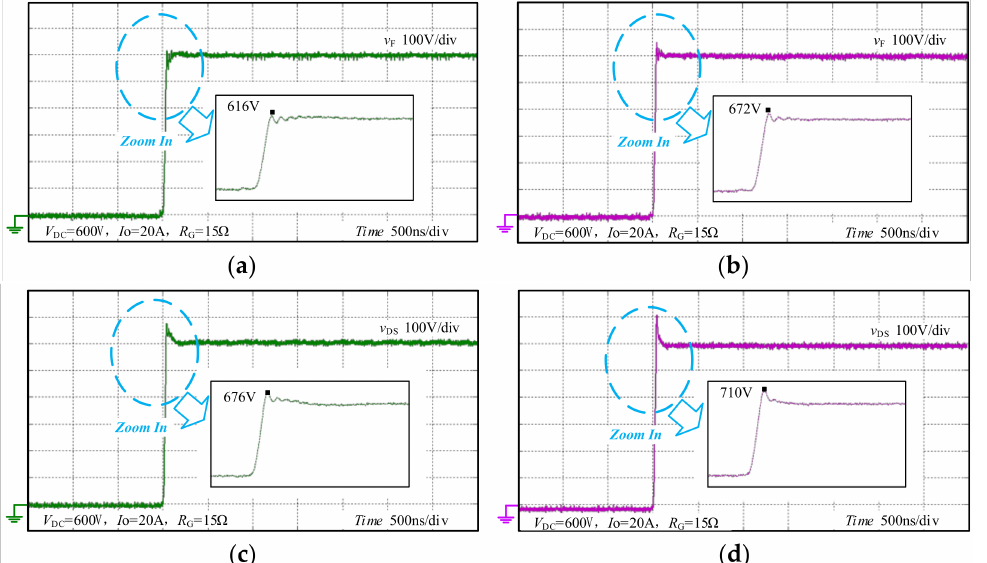
Figure 11. Tested waveforms with capacitor C DE and resistor R DE . ( a ) Turn-off voltage of the SiC diode at C DE = 100 nF and R DE = 2.5 Ω , ( b ) turn-off voltage of the SiC diode at C DE = 100 nF and R DE = 5 Ω , ( c ) turn-off voltage of the SiC MOSFET at C DE = 100 nF and R DE = 2.5 Ω , and ( d ) turn-off voltage of the SiC MOSFET at C DE = 100 nF and R DE = 5 Ω